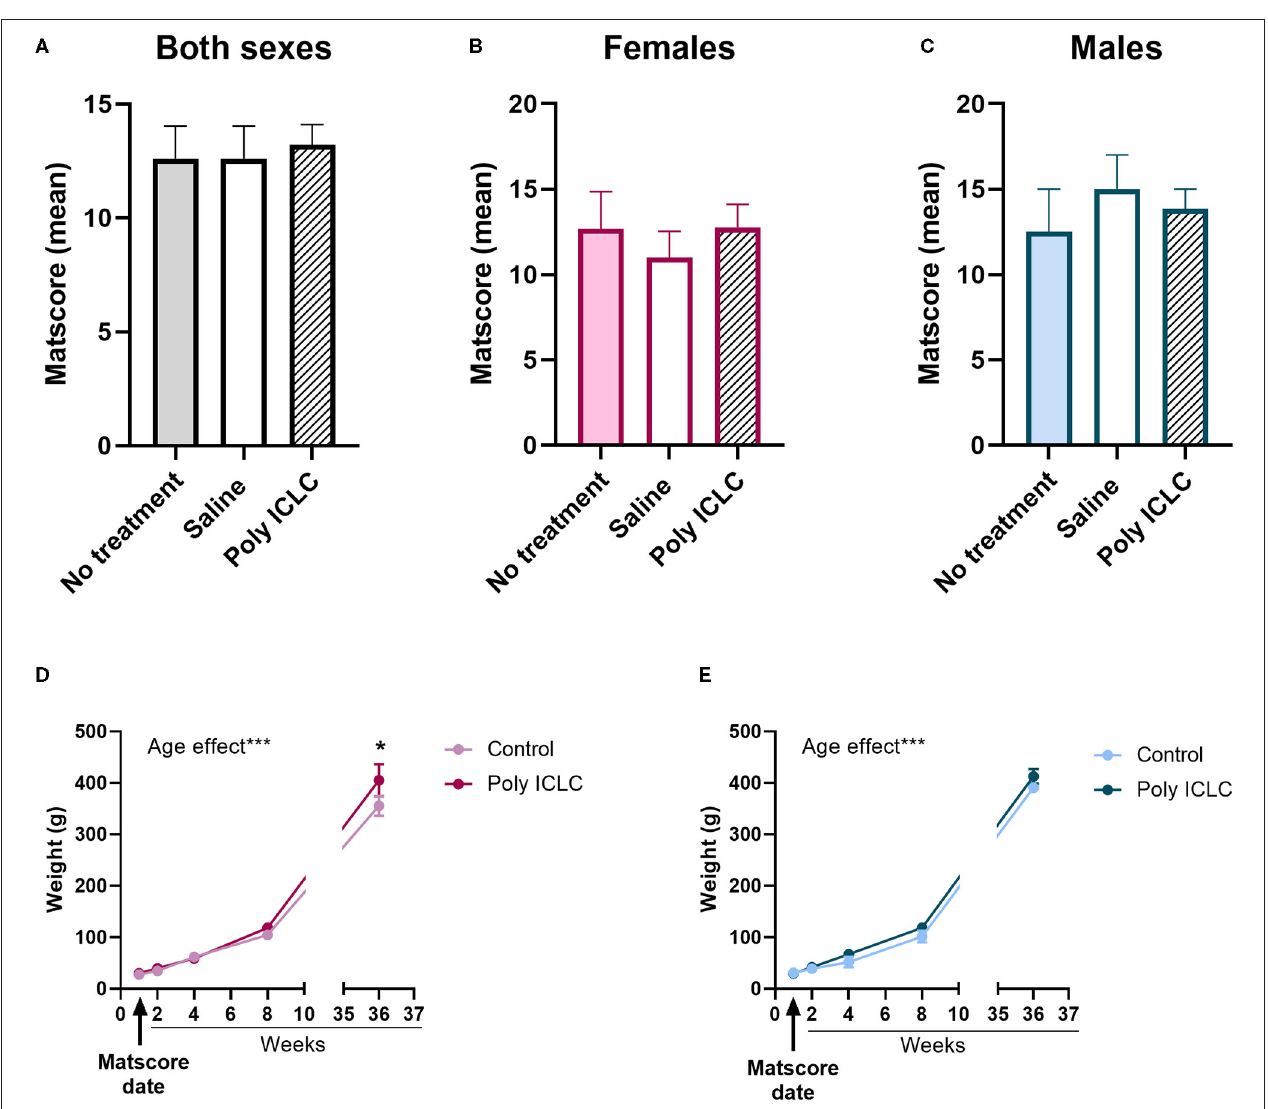
FIGURE 2 | Offspring Developmental outcomes. Matscore test results at the first couple of days of age in (A) male and female offspring together, (B) female offspring alone, or (C) male offspring alone. (A) No treatment group n = 5, Saline group n = 5, Poly ICLC group n = 7. (B) No treatment group n = 3, saline group n = 3, Poly ICLC n = 4. (C) No treatment group n = 2, saline group n = 2, and Poly ICLC n = 3 Data are expressed as mean ± SEM analyzed with One-Way ANOVA. Offspring weight was recorded from MASTSCORE date to the 37th weeks of age in (D) female and (E) male offspring. Data are expressed as mean ± SEM analyzed with Two-Way ANOVA with repeated measures followed by a Bonferroni post-hoc . * p < 0.05 and *** p < 0.001.